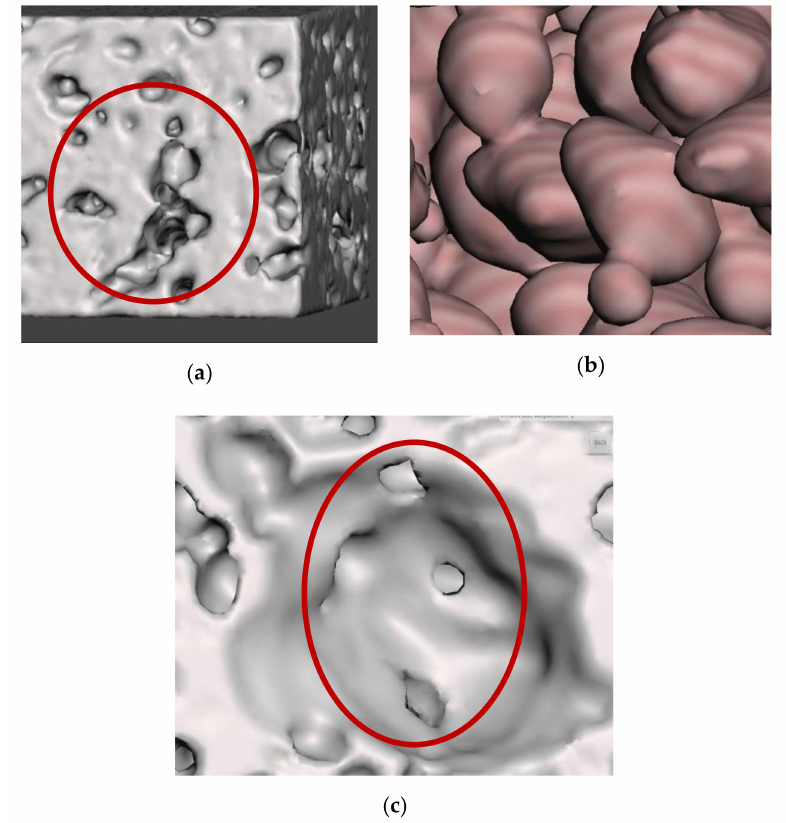
Figure 12. Structure of the foam ( a ) continuation of pore walls, ( b ) pores of different size joined inside the foam, and ( c ) pore wall